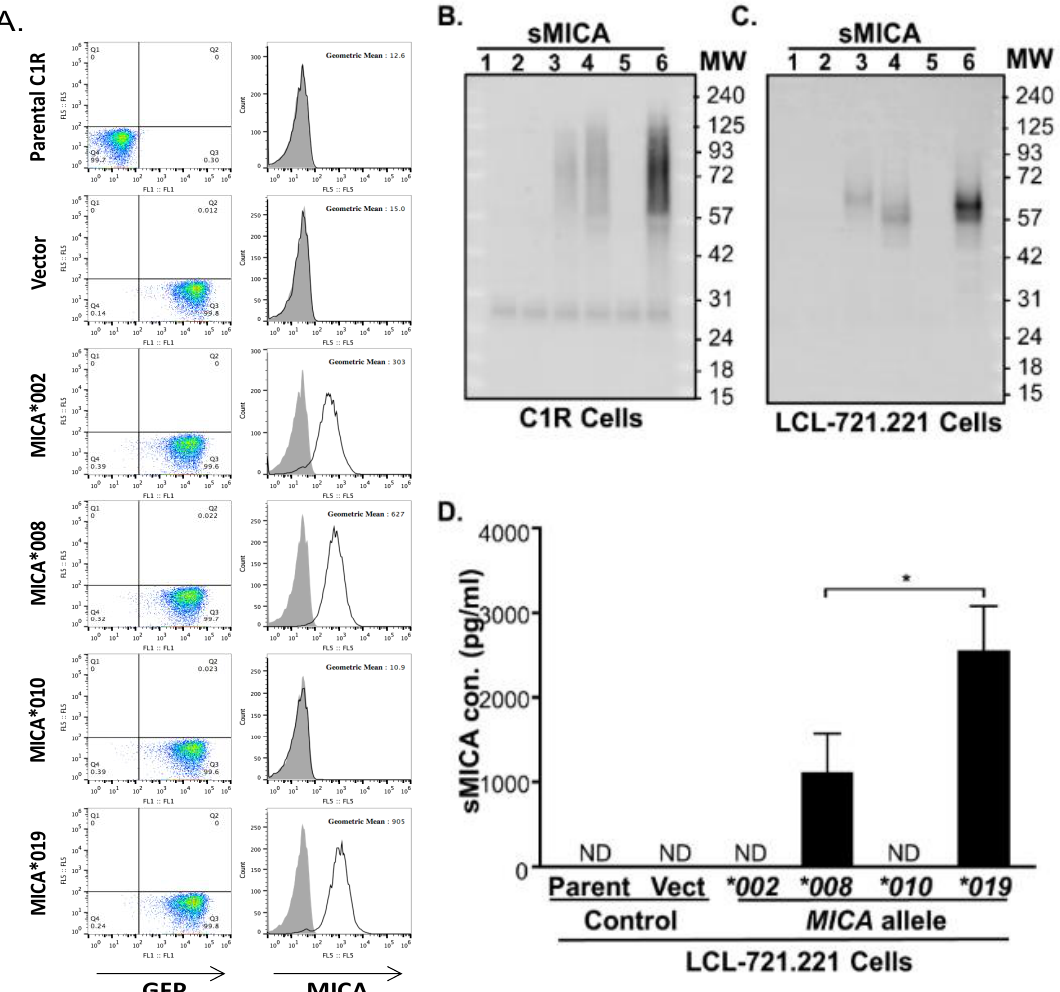
Figure 2. Surface expressions and soluble MICA (sMICA) productions of MICA alleles. ( A ) Representatives of transduced cells expressing vector and MICA alleles ( MICA*002 , MICA*008 , MICA*010 and MICA*019 ) were sorted for equivalent GFP expressions (left panels). The MICA*019 cells expressed the highest level of surface MICA (geometric mean: 905), as compared to MICA*002 (geometric mean: 303) and MICA*008 (geometric mean: 627) cells, while MICA*010 cells failed to express surface MICA on cell membrane. ( B ) Western blot analysis of sMICA produced by C1R cells expressing MICA alleles. Ultracentrifugation was used to separate cell-free culture supernatants into supernatant fractions containing